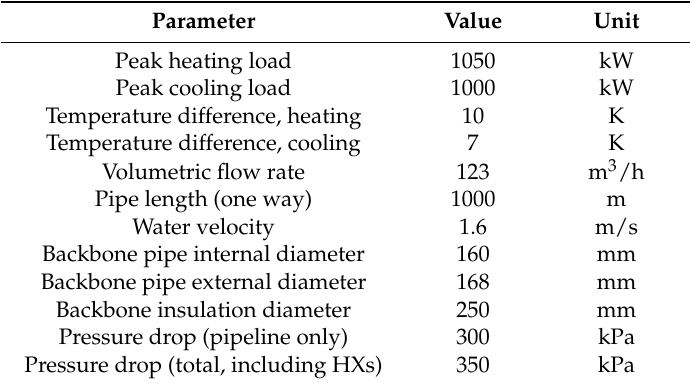
Table A4. Network design parameters for the reference